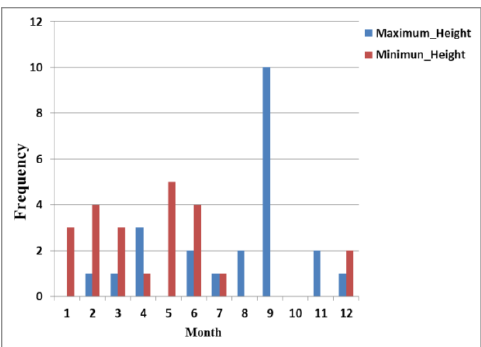
Figure 6. Monthly distribution of maximum and minimum water level from 1992 to